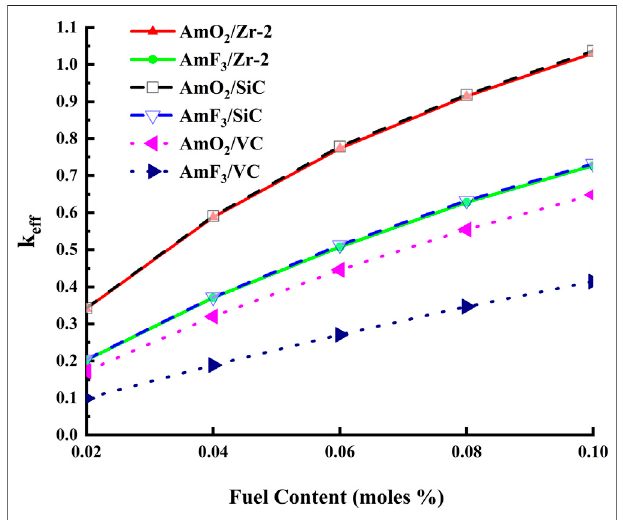
FIGURE6| The fi ssionenergyvaluesforZr-2,SiC,andVCclads,thefuel components AmO 2 and AmF 3 in the BWR